Question: In one sentence, what is this figure communicating?
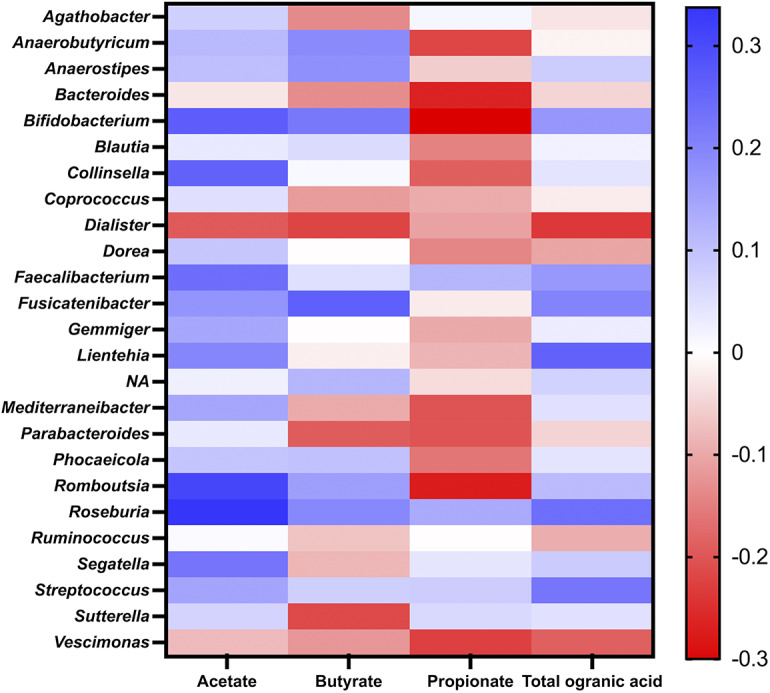
Answer: Heatmap of Spearman’s rank correlations between bacterial genera and SCFA log₂–fold-changes across the full cohort (n = 37). Spearman’s ρ (two-sided) was calculated for each genus–SCFA pair and adjusted for multiple testing with the Benjamini–Hochberg FDR. ρ values range from −0.3 (strong negative) to +0.3 (strong positive); colour intensity reflects the magnitude and direction of ρ (blue = negative, red = positive). Asterisks denote correlations surviving FDR (q < 0.05). Abbreviations: NA, not assigned at the sequencing level. Figure 8. long description.